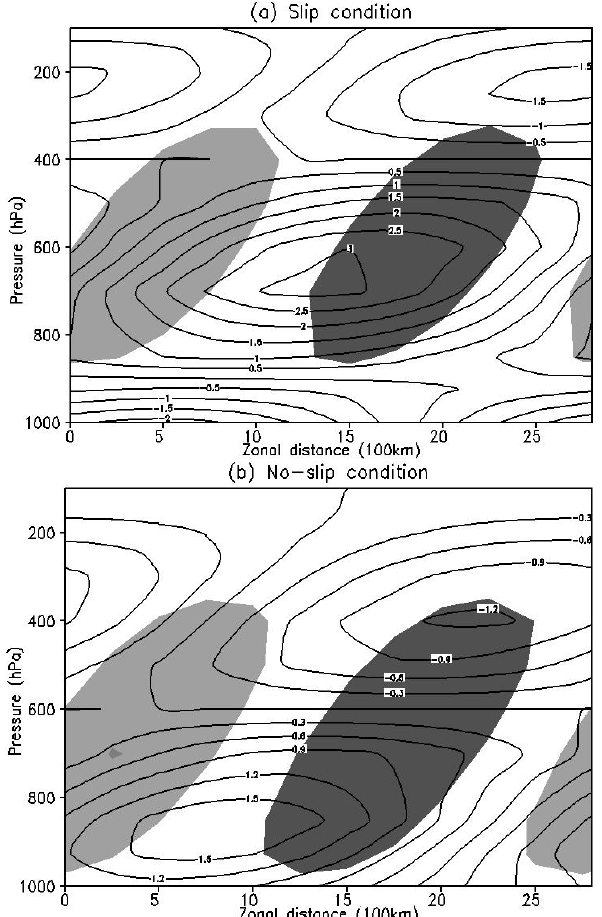
Fig. 5. Vertical cross section along 15 ◦ N of the normal mode ( λ = 2900km) for (a) slip ( ε = 1) and (b) no-slip ( ε = 0) boundary condition for K = 0. Solid contour line is total relative vorticity. Ver- tical velocity is also indicated by heavy shading (ascent) and light shading (descent). Contour interval for vorticity is 0 . 5 × 10 − 5 s − 1